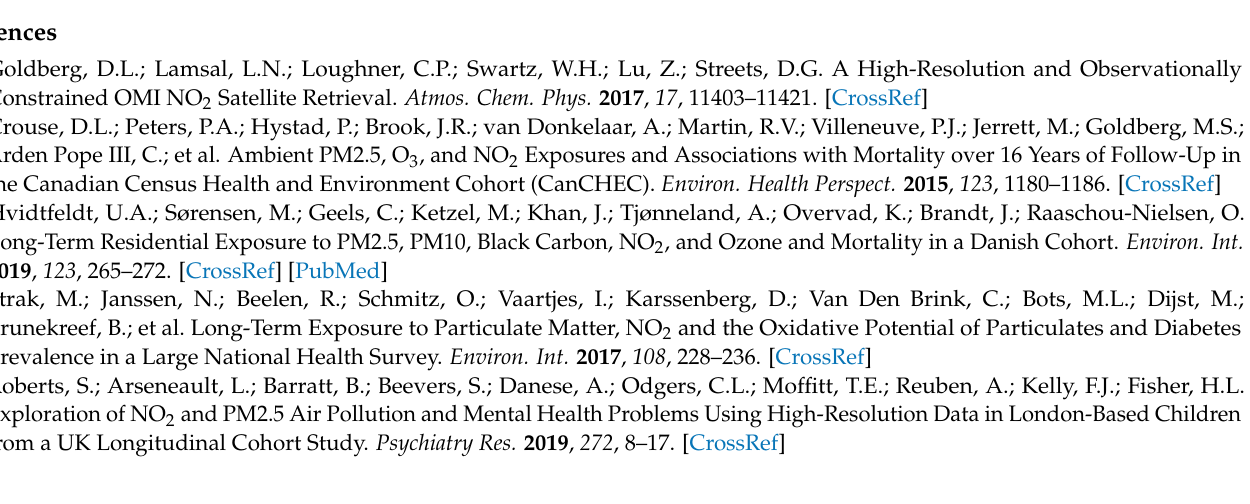
10.3390/atmos12091142/s1, Figure S1: Spatial distribution of surface air quality monitoring stations in YREB; Figure S2: Scatter plots of the TROPOMI NO 2 VCD and in situ measured NO 2 concentrations for all seasons. Table S1: Descriptions of 17 potential influencing factors on NO 2 VCD; Table S2: The seasonal average of the NO 2 VCD in 11 provinces and cities in the YREB; Table S3: The 10 cities with the highest NO 2 VCD in YREB in each season from 2019 to 2020 ( µ mol/m 2 ); Table S4: The optimal classification method of NO 2 VCD potential impact factors and the highest value range of NO 2 VCD for each impact factor in